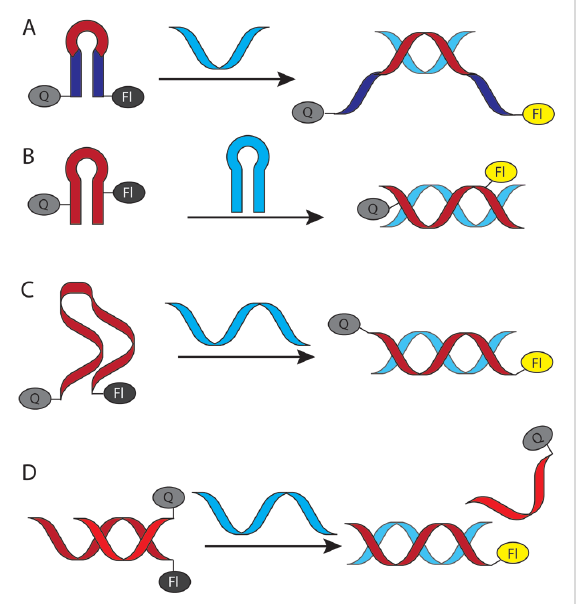
Figure 23: Molecular beacons containing generic fluorophores (Fl) and quenchers (Q) recognizing a complementary oligonucleotide. (A) PNA/ DNA chimeras [244] (PNA in red, DNA in blue) and (B) PNA [245] with self-complementary stems were originally used to ensure close prox- imity of the fluorophore and quencher; (C) stemless beacons [246] lack partially self-complementary sequences instead relying on PNA aggre- gation to keep the fluorophore and quencher in proximity; (D) two com- plementary PNAs can also be used to ensure the proximity in dsPNA beacons.